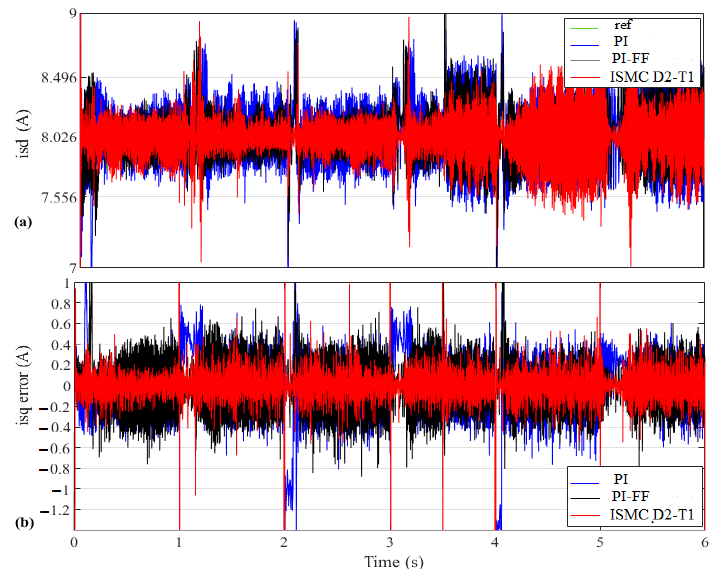
Figure 8. Experimental tests for i sd and i sq performance comparison between the enhanced ISMC D2 design and the PI regulators with 600-rpm reference speed: ( a ) i sd and ( b ) i sq error.